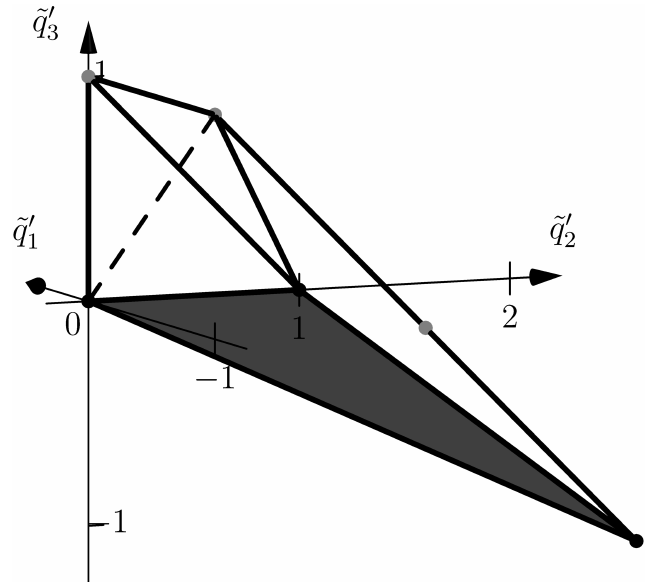
Figure 4. The polyhedron Γ ( f 3 ) of the third equation of the system (11). The selected face corresponds to the third equation of the truncated system